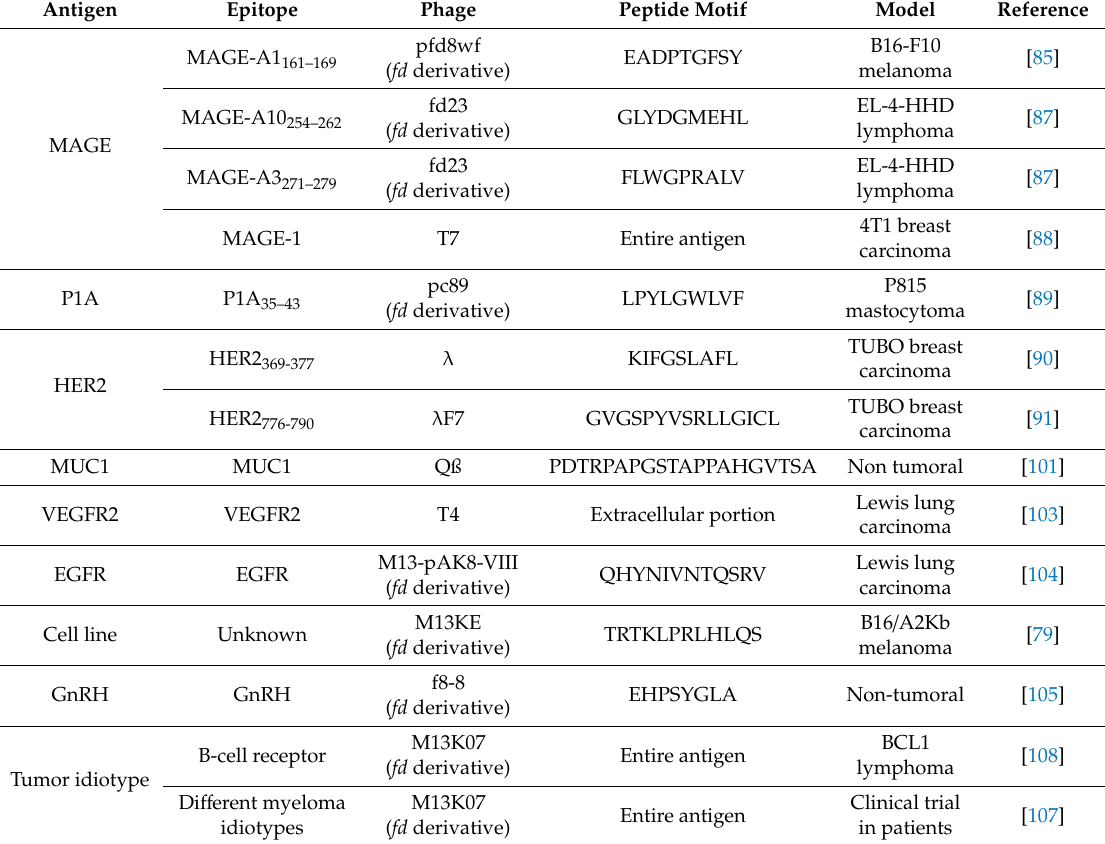
Table 2. Phages as nanocarriers for anticancer